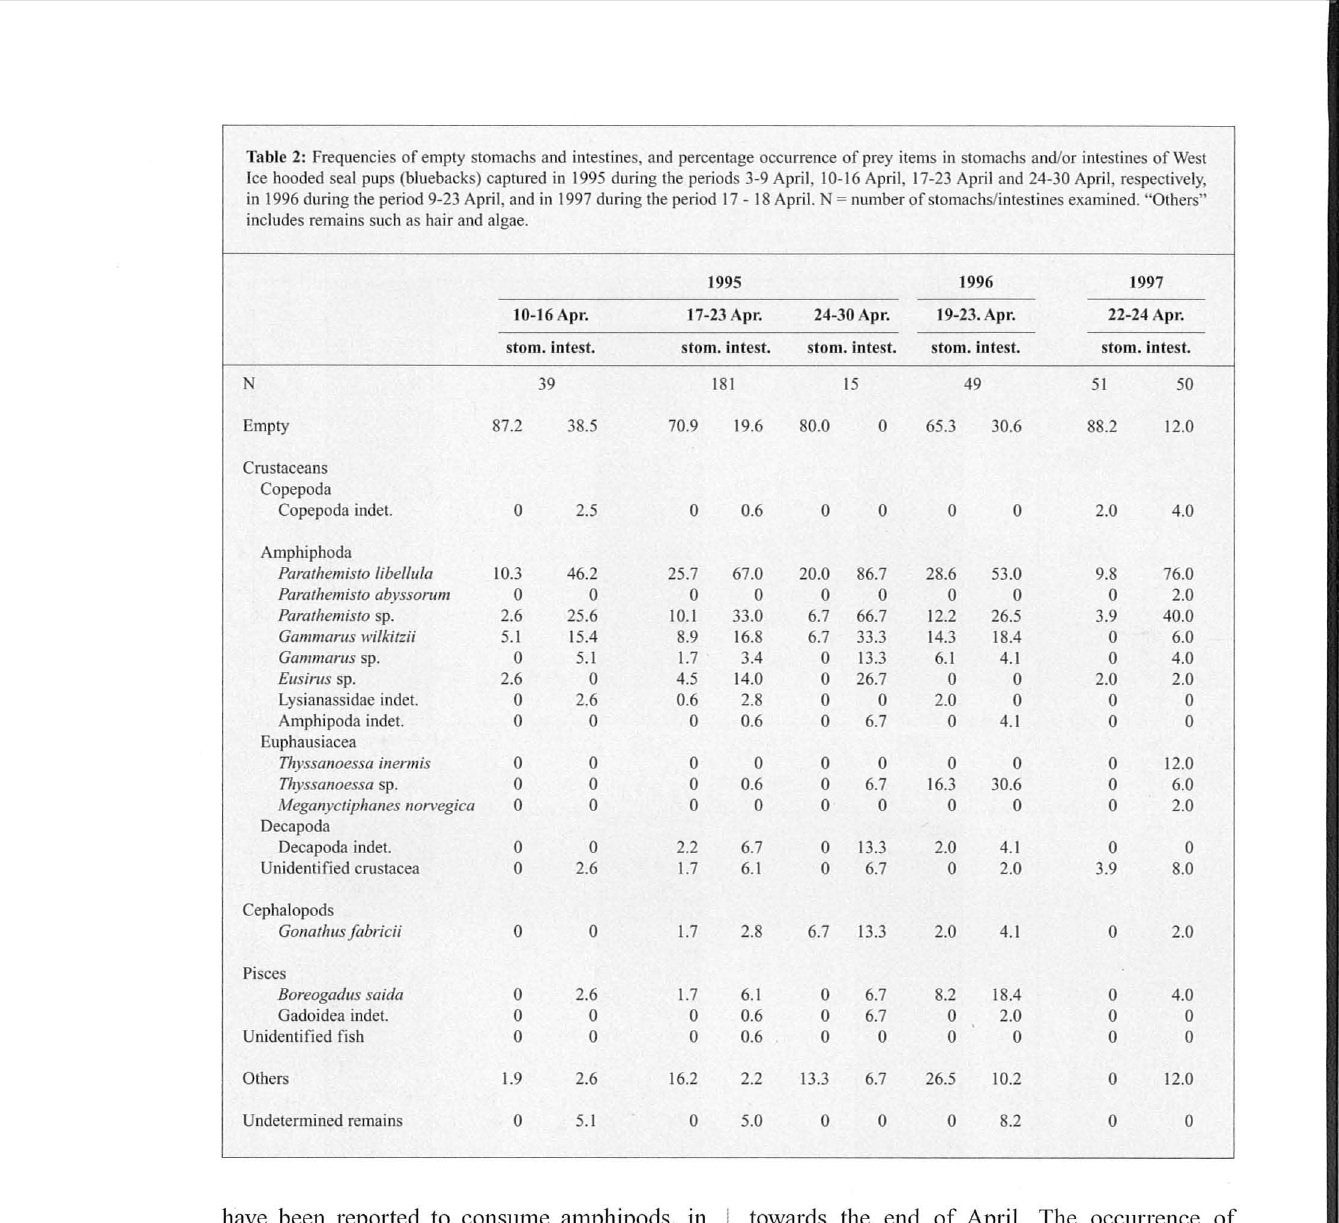
Table 2: Frequencies of empty stomachs and intestines, and percentage occurrence of prey items in stomachs and/or intestines of West Ice hooded seal pups (bluebacks) captured in 1995 during the periods 3-9 April, 10-16 April, 17-23 April and 24-30 April, respectively, in 1996 during the period 9-23 April, and in 1997 during the period 17 - 18 April. N = number of stomachs/intestines examined. "Others" includes remains such as hair and algae.